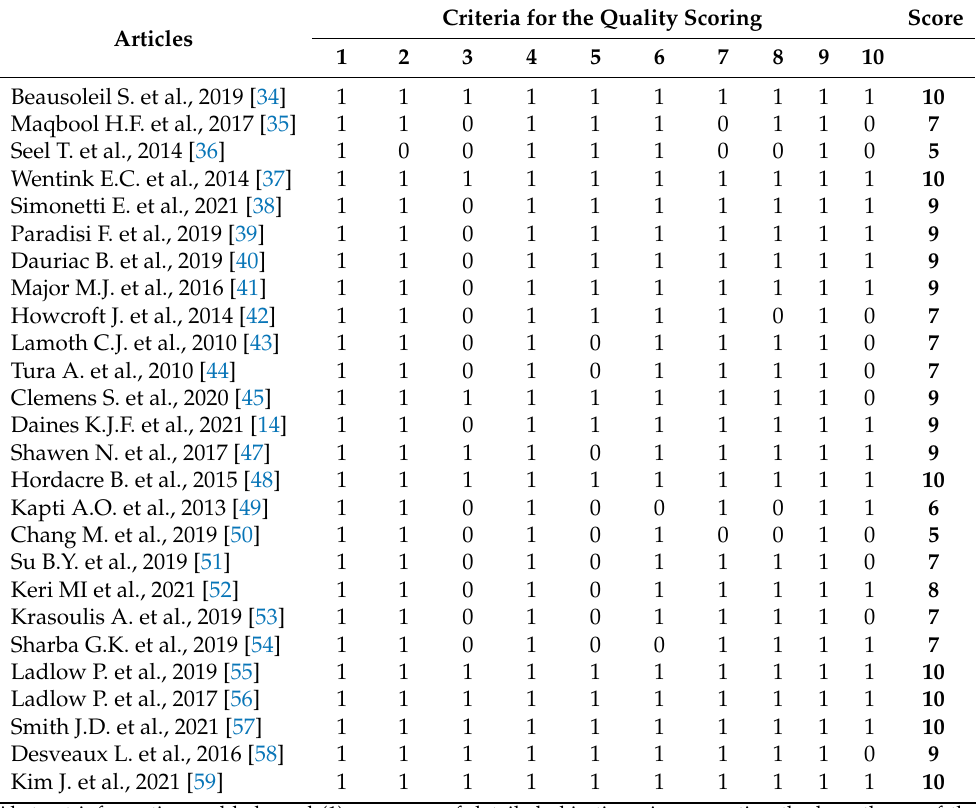
Table 2. Methodological assessment of the included studies. Criteria for the Quality Articles